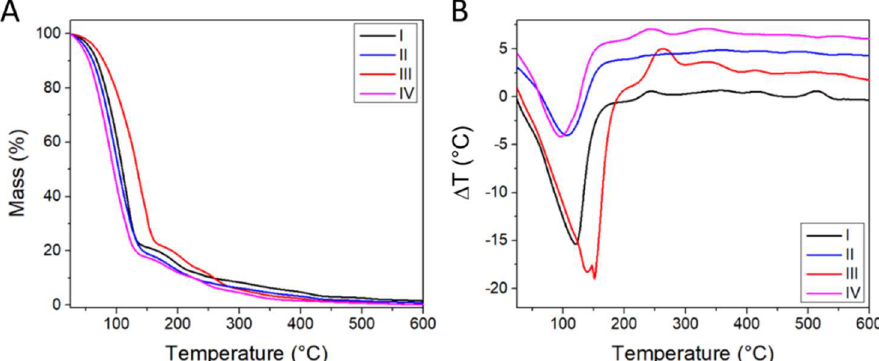
Figure 2. ( A ) Thermogravimetric Analysis (TGA) and ( B ) Differential Thermal Analyses (DTA) results for the different formulations. Each curve in ( B ), with the exception of formulation I, is shifted by +2 °C with respect to the previous one, for clarity.